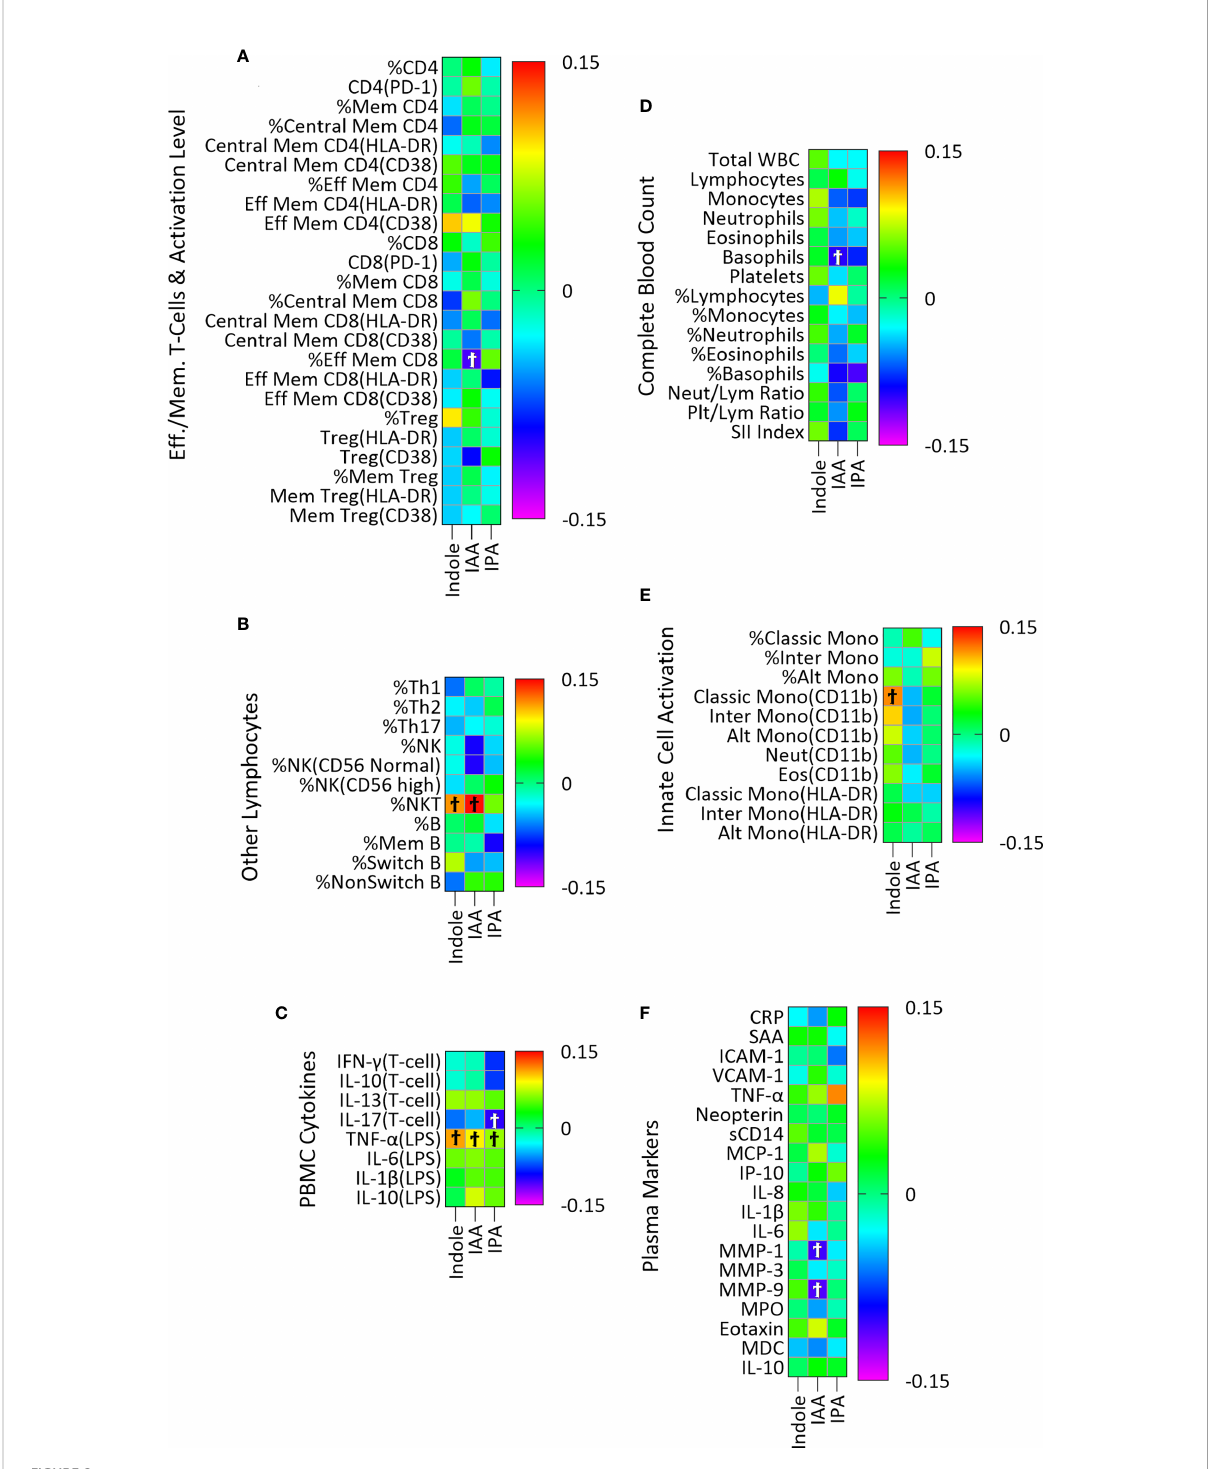
FIGURE 2 Association of plasma indole, IAA and IPA with plasma markers of immune activity in a linear regression model adjusted for age, sex, and BMI categories and CMV infection status. The association of IPA with immune markers was also adjusted for YMCA step scores. Heatmaps (A – F) show coef fi cients of association with adjusted beta values for the six immune groupings (A) Effector/Memory T-cells and activation level (n = 24), (B) Other lymphocytes including Th cells, NK, NK T-cells and B cells (n=11), (C) PBMC cytokines (n=8), (D) Complete Blood Count (n = 15), (E) Innate cell activation (n=11), and (F) Plasma (n = 19). ‘ Ϯ ’ indicates signi fi cant with unadjusted p values<0.05. No signi fi cant associations were seen using with Benjamini-Hochberg adjusted p-values